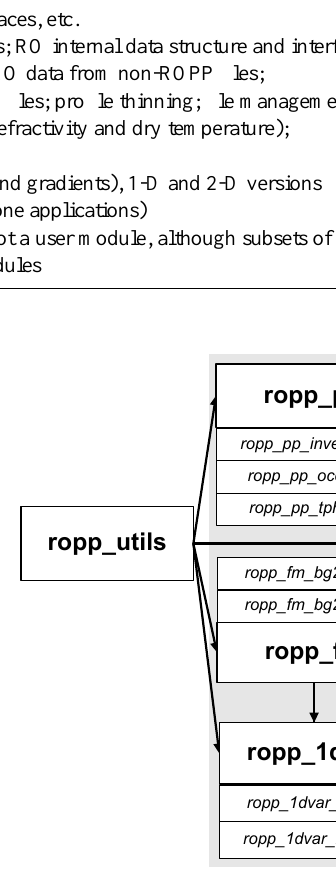
Figure 1. The modules (bold) and tools (italic) within ROPP-7.0. The module at the head of an arrow depends directly on the module at its